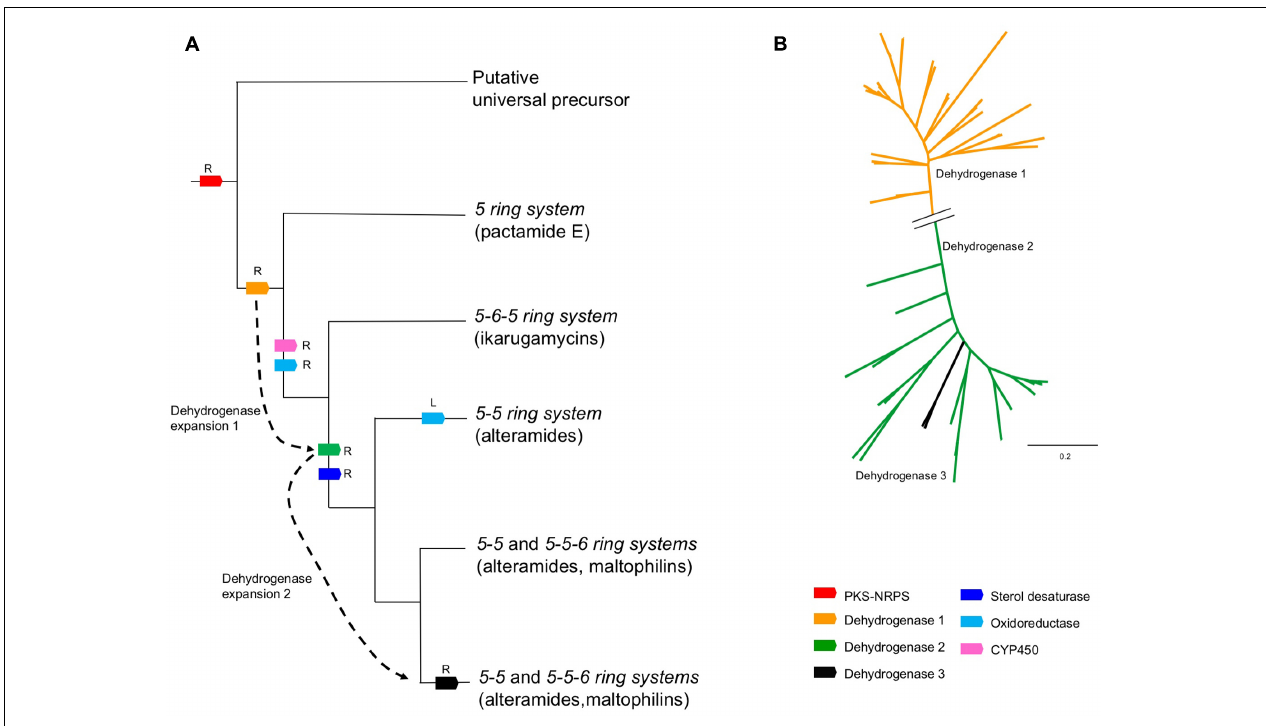
FIGURE 6 | Biosynthetic evolution of PTMs. (A) Reconstruction of the evolutionary events leading to the chemical diversity of PTMs. The branches of the cladogram show the products of each evolutionary event. Gene recruitment events are indicated with an R, and gene losses with an L. Dotted arrow indicate expansions of the PTM dehydrogenases gene families, which led to major changes in ring composition in PTMs. (B) Phylogenetic reconstruction of PTM dehydrogenases. A broken line in the tree indicates the distant relationship between dehydrogenases in clades 1 and 2. Recently evolved family 3 is likely derived from a duplication event in family